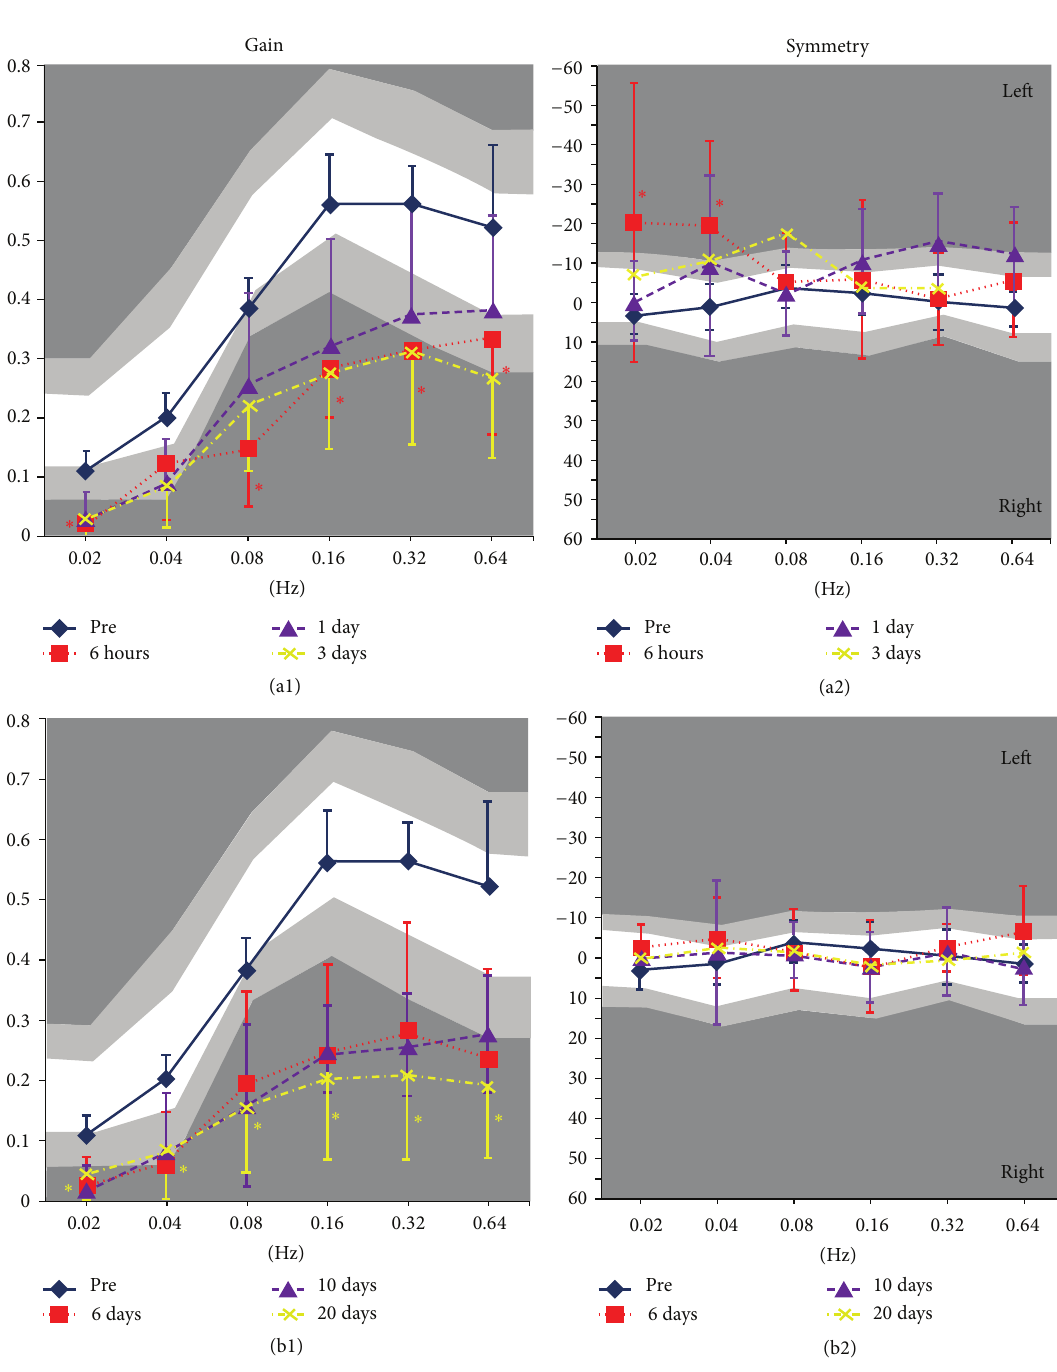
Figure 3: Sinusoidal harmonic acceleration (SHA) test results after cochleostomy. Before cochleostomy, gain in the SHA test was within the normal range, that is, within two standard deviations of the mean, for all rotation frequencies. However, at 6 hours after cochleostomy, the gain had decreased significantly (a1). After 6, 10, and 20 days, the gain tended to deteriorate with time (b1). Concerning symmetry, the values were within the normal range at all frequencies before cochleostomy; at 6 hours after cochleostomy, the asymmetry significantly deviated toward the side operated on at low frequencies (a2); the deviation recovered slightly after 1 and 3 days but still did not reach the normal range (0.08 Hz) (a2). After 6, 10, and 20 days, the asymmetry recovered and values were within the normal range (b2). White areas indicate normal range, light gray shadow indicates mean ± 1 SD, and dark gray shadow indicates mean ± 2 SD. ∗ 𝑝 < 0.05